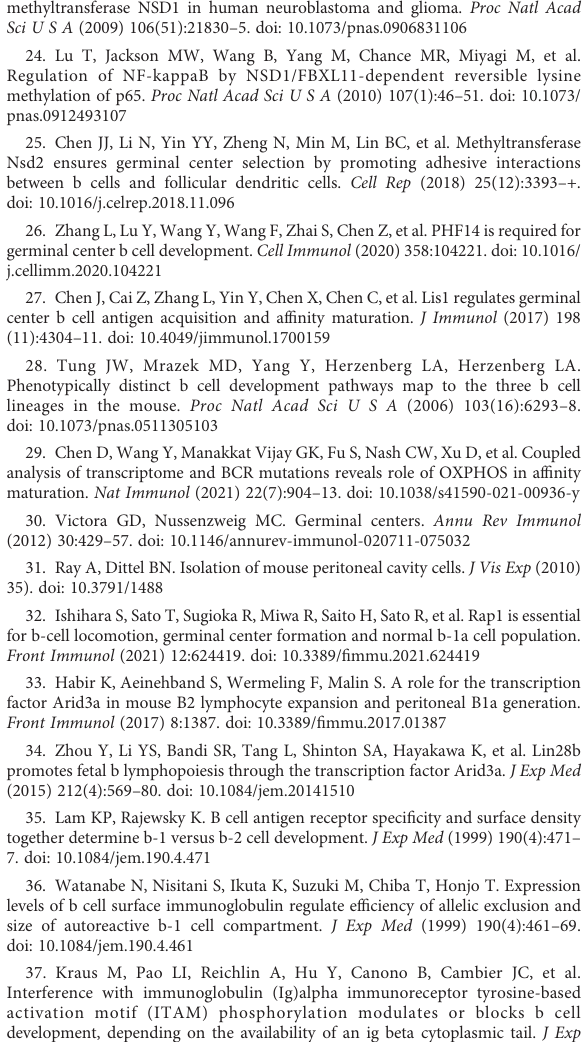
fromthespleenofNSD1 BWT andNSD1 BKO mice. (C) .ThefrequencyofGC B cells that acquired indicated higher-af fi nity mutations (W33L/K59R/ 99G) sorted from the spleen of NSD1 B WT and NSD1 B KO mice. SUPPLEMENTARY FIGURE 4 Gene Ontology (GO) enrichment and KEGG enrichment analysis of the different expression genes. (A) . Gene Ontology enrichment analysis of the different expression genes. (B) . KEGG enrichment analysis of the different expression